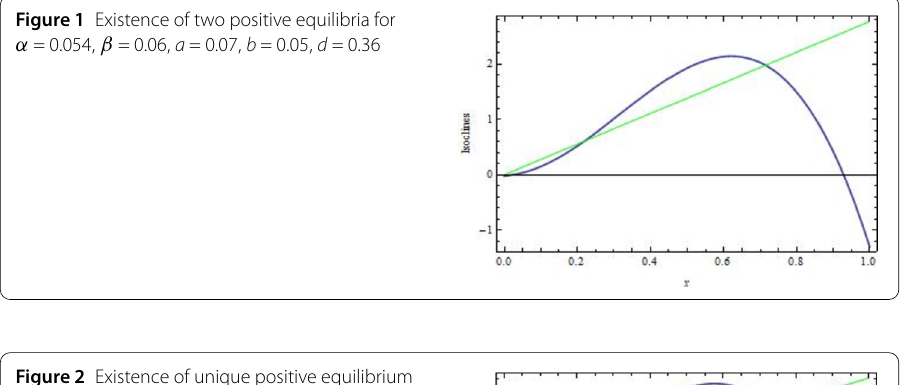
Figure 2 Existence of unique positive equilibrium for α = 0.042, β = 0.59, a = 0.155, b = 0.465, d = 0.38